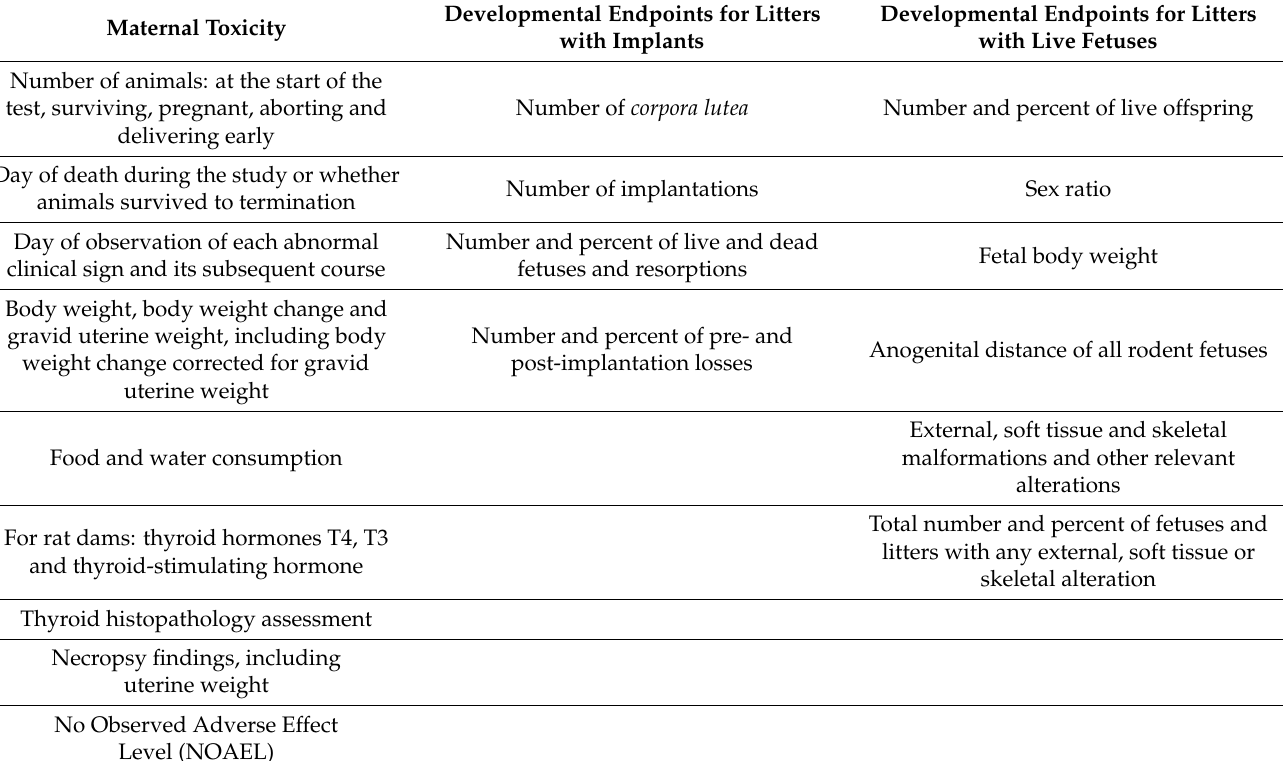
Table 1. Endpoints to be assessed in an OECD TG 414 test; the effects should be reported by the dose